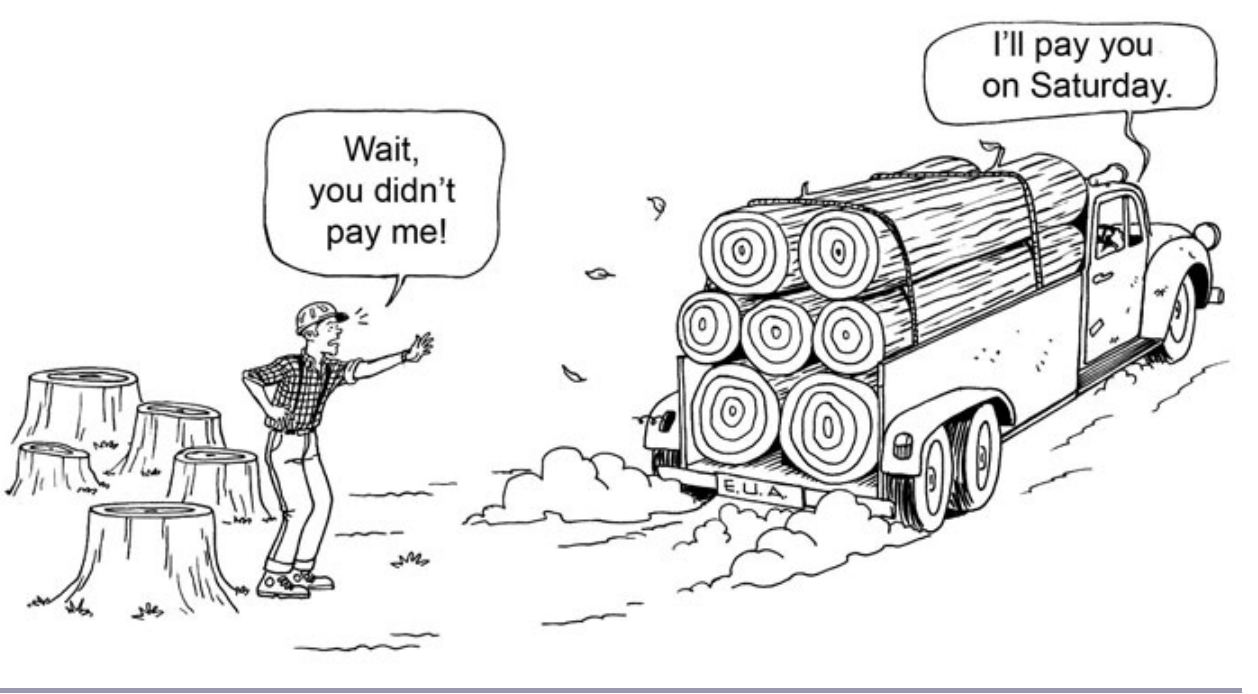
Fig. 9. A well-informed American professor of forestry also loses out to a logger. Source: Shanley and Medina